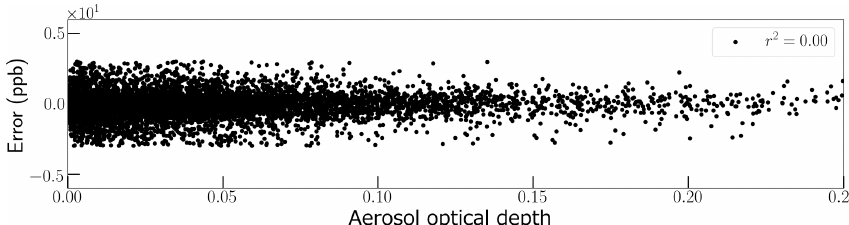
Figure 15. Scatter plot of retrieved AOD vs. total uncertainty in the 13 CH 4 column from the SWIR1 band. The coefficient of determination is indicated in the